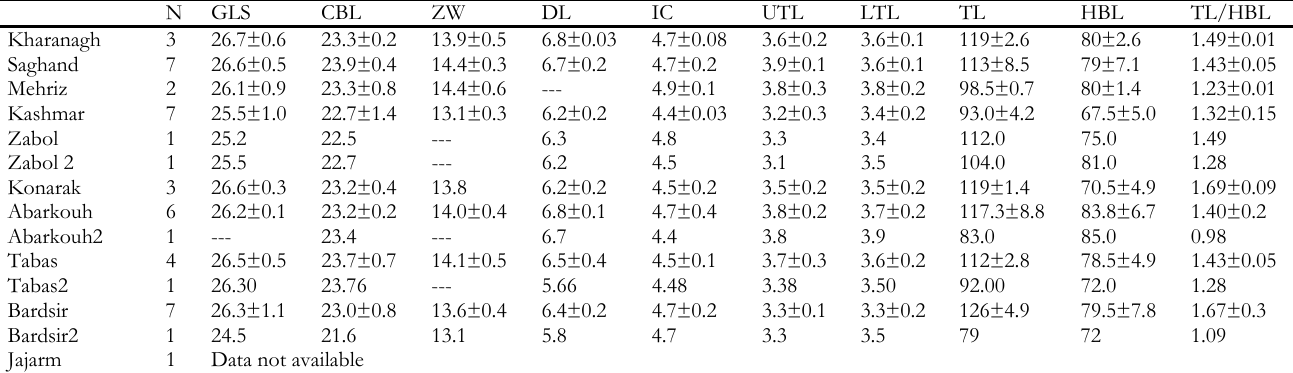
T ABLE 2.- Selected measurements (in mm) of different populations of Gerbillus nanus (Mean ± SD). See